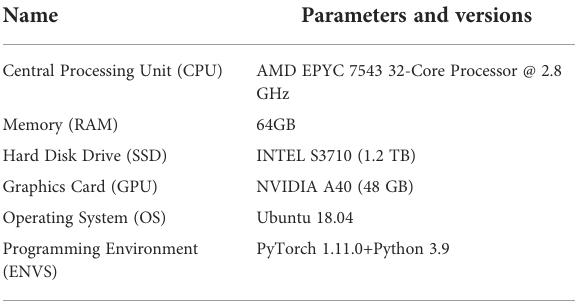
TABLE 1 Experimental software and hardware